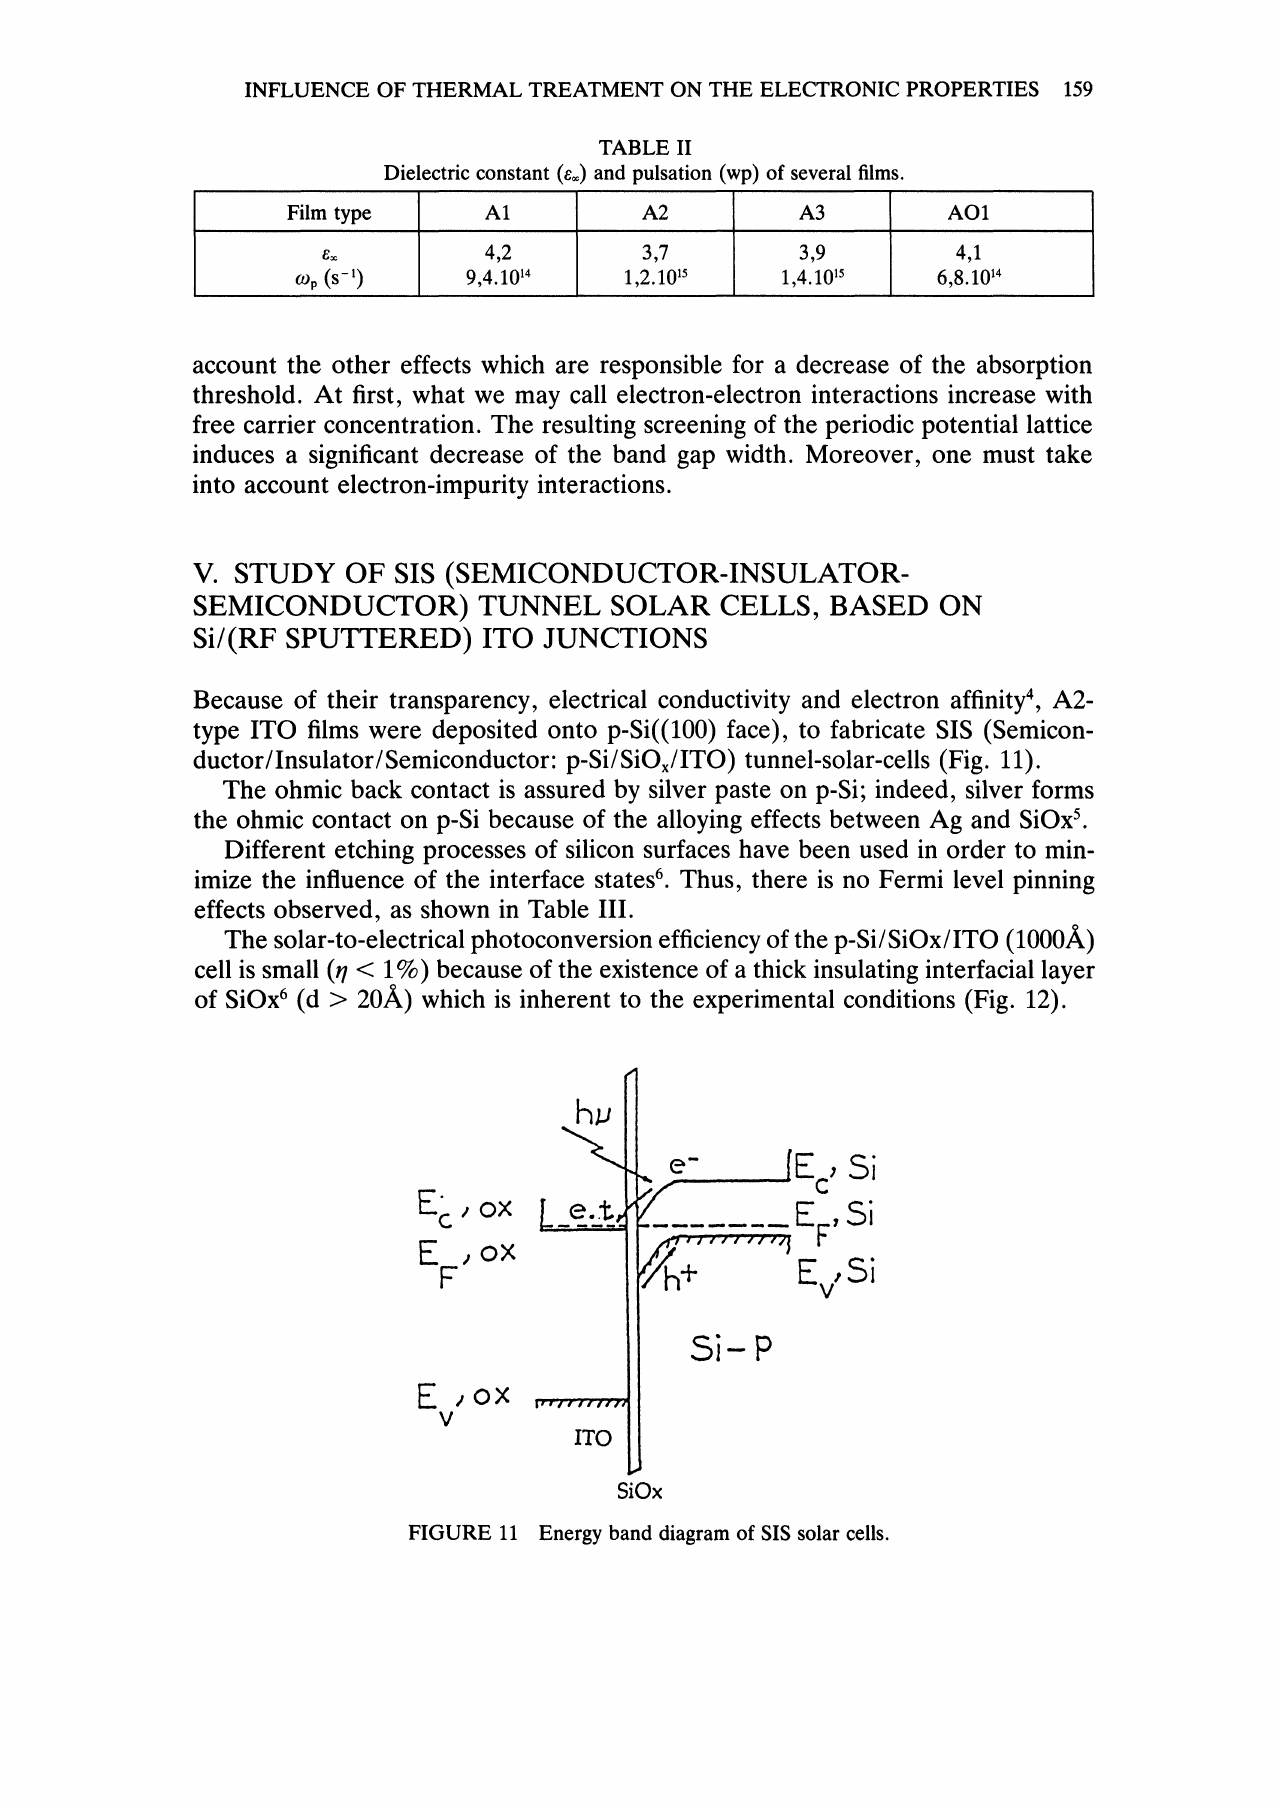
Dielectric constant (e) and pulsation (wp) of several films.